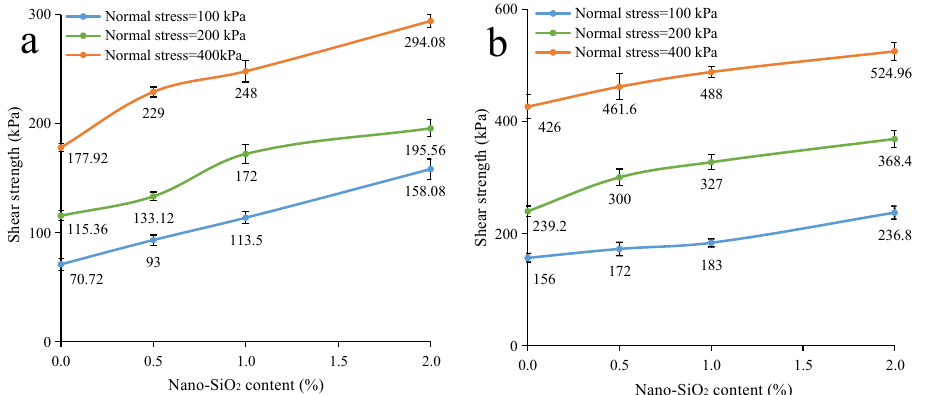
Figure 6. The shear strength of nano-SiO 2 -reinforced clayey soil ( a ) under uncured conditions ( b ) under the cured conditions ( Values are means ± S.E.M.).